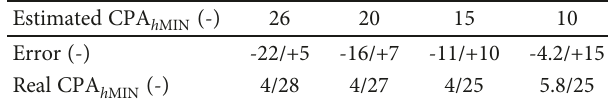
Table 5: CPA h MIN estimation results.